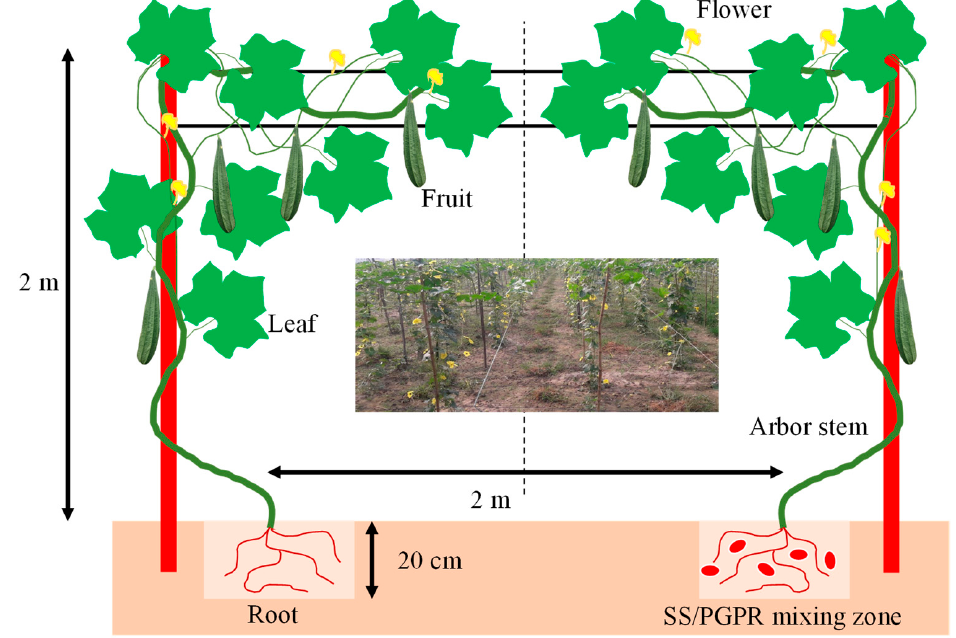
Figure 1. View of the experimental setup for Ridge gourd ( L. acutangula ) cultivation under sewage sludge (SS) and plant growth-promoting rhizobia (PGPR) treatments.